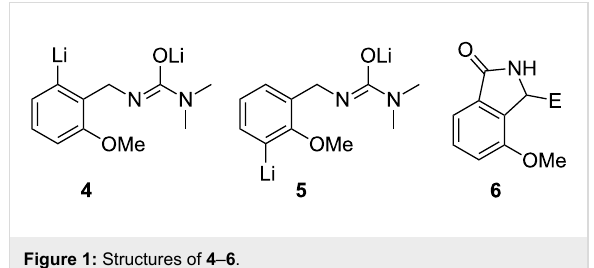
Figure 1: Structures of 4 – 6